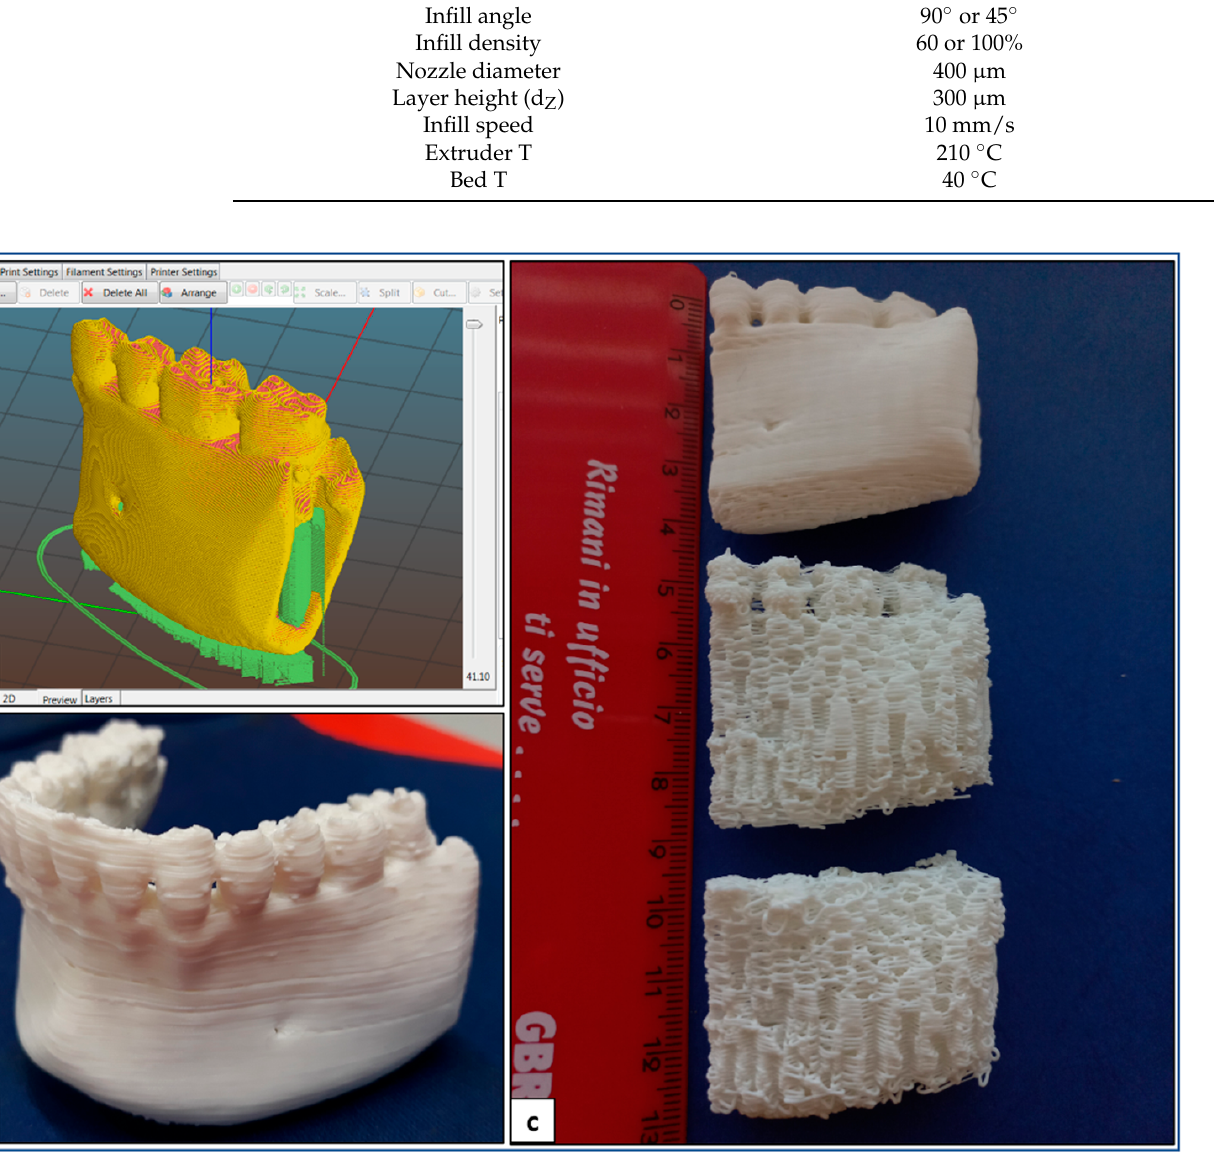
Figure 4. AM of PLA: ( a ) digital model of a lay-down pattern; ( b ) representative picture of lower jaw physical model; ( c ) representative picture of physical models and porous scaffolds of madibular bone segment.